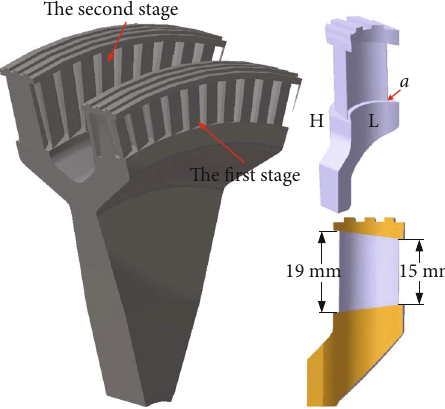
Figure 1: Parts of the turbine rotor.